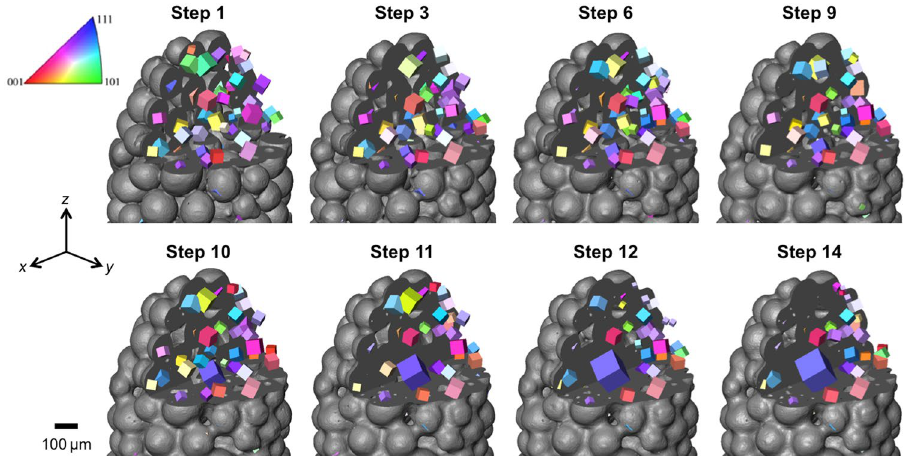
Figure 5. Microstructural evolution, both morphological and crystallographic, during densification of the powder body. Time-series showing the absorption tomography volumes (black and white surface representation) of the copper particle sample for several steps through the sintering sequence. The crystallographic microstructure within the sectioned region is revealed, allowing grains to be tracked through the time steps. The colourmap represents crystallographic orientation according to inverse pole figure; the cubes are scaled by 0.5 according to the respective grain size to allow for easier visualization of all the grains in the image.